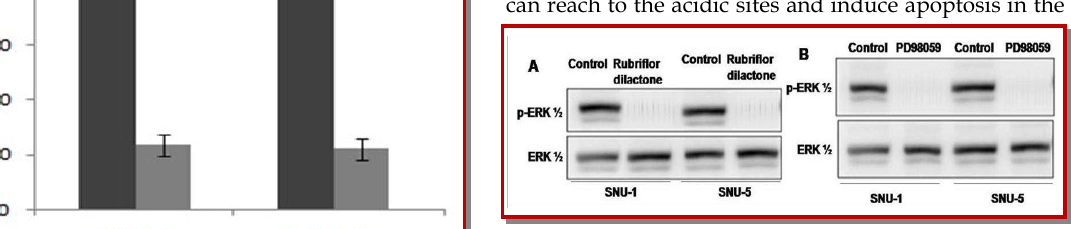
Figure 5 : Rubriflordilactone A induced suppression in p ‑ ERK 1/2 expression in SNU-1 and SNU-5 cancer cell lines. (B) ERK 1/2 inhibitor, PD98059 inhibited expression of p ‑ ERK 1/2 in SNU-1 and SNU-5 cancer cell